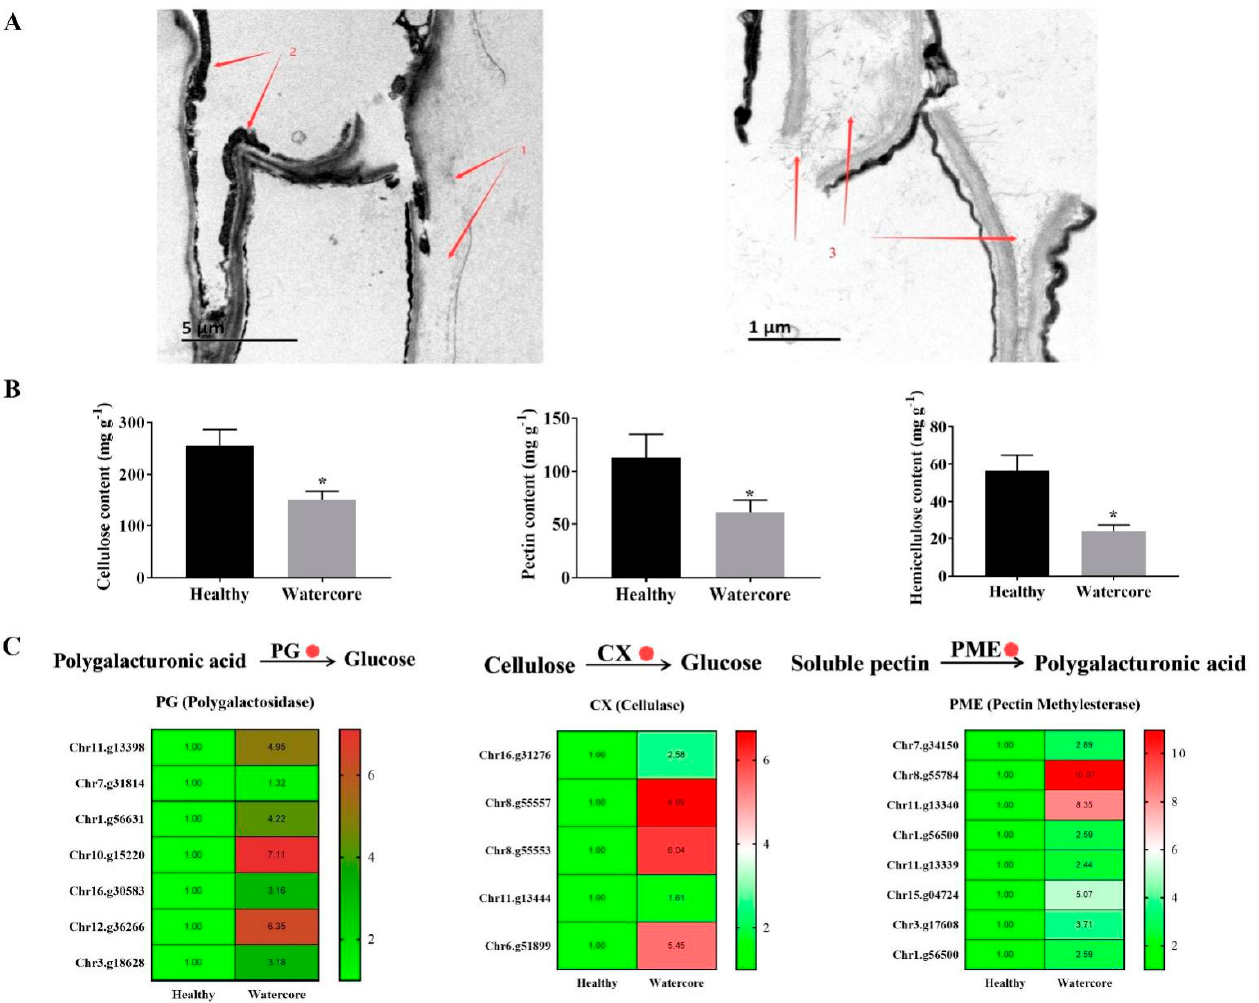
Figure 3. Transmission electron microscopy ( A ), cell wall components ( B ) analysis and their metabolism-related gene expression ( C ) in watercore fruit. Red 1–3 refer to cell wall, residual cytoplasm and cell wall cellulose, respectively. The red circle refers to up-regulation of gene expression. * The asterisk on the bars indicates significant differences between the watercore and healthy fruit at p < 0.05.